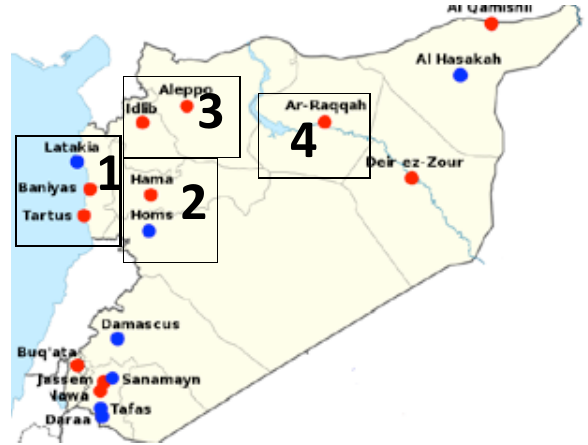
Figure 1. A map of Syria showing the four agro-ecological regions where durum wheat fields were surveyed for leaf rust in